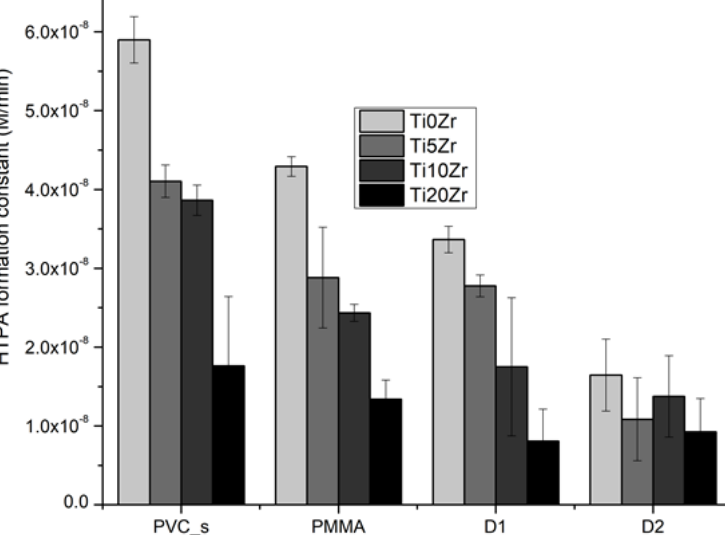
Figure 8. Photocatalytic activities determined by the formation constant of hydroxyterephthalic acid. Error bars represent standard error of the mean (N = 3; three different spots on the sample, as suggested in ref. [48]).